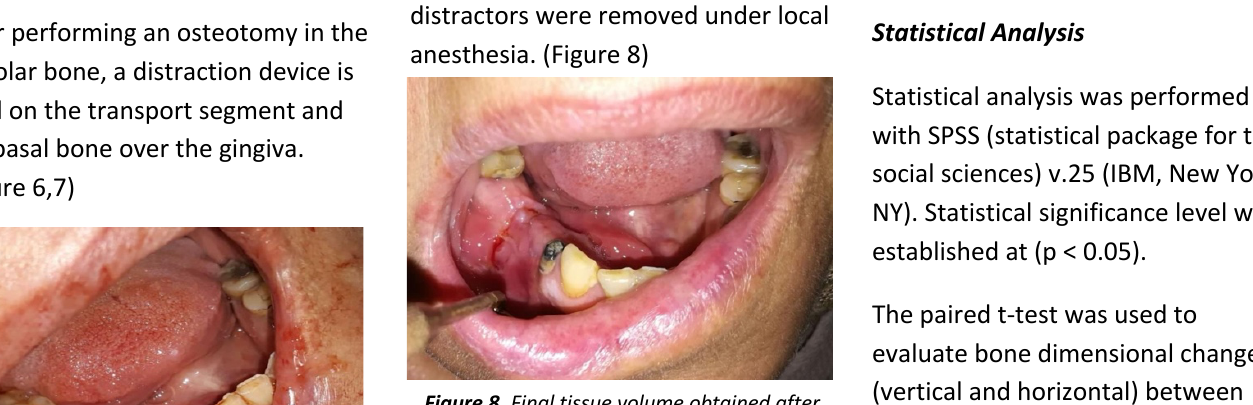
Figure 9. CBCT radiograph after 3 months of the alveolar osteogenic distraction surgery confirming the bone gain obtained.